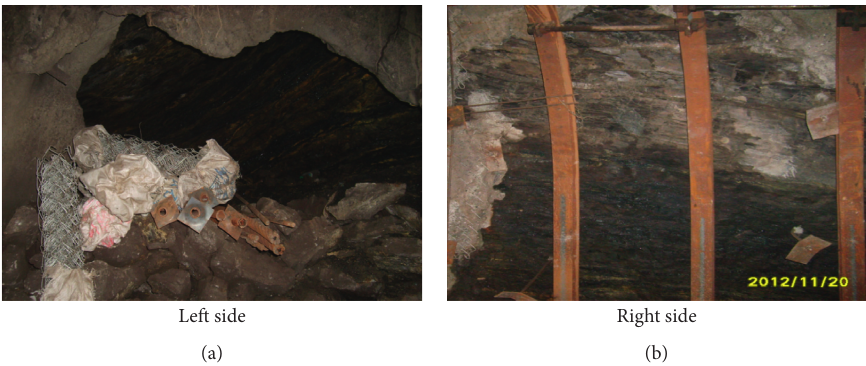
Figure 5: The damage of the surrounding rock. (a) Left side. (b) Right side.